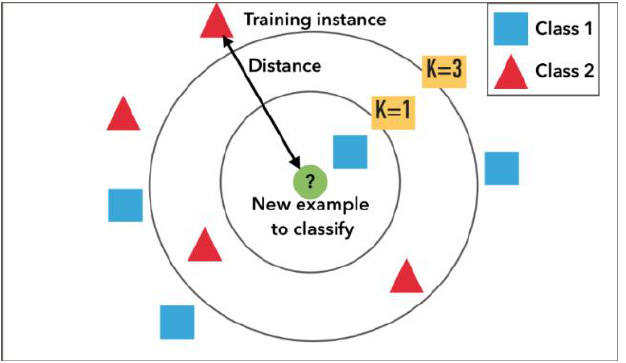
Figure 6. kNN representation [32].